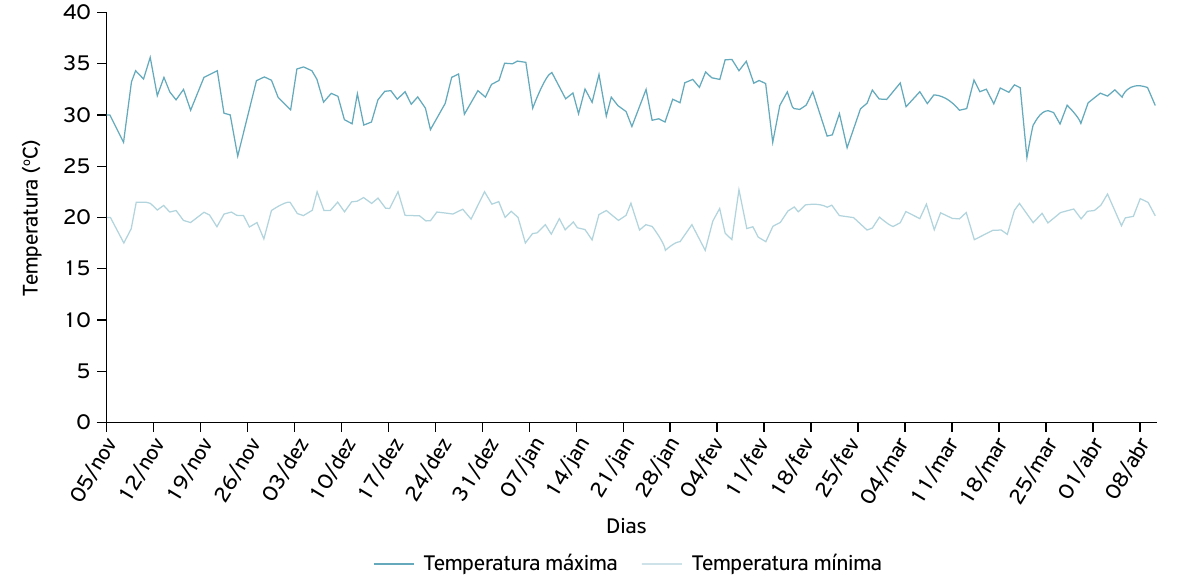
Figura 1. Temperatura máxima e mínima, a cada sete dias, durante o período de condução do experimento. Jataí, Goiás, 2013/2014.